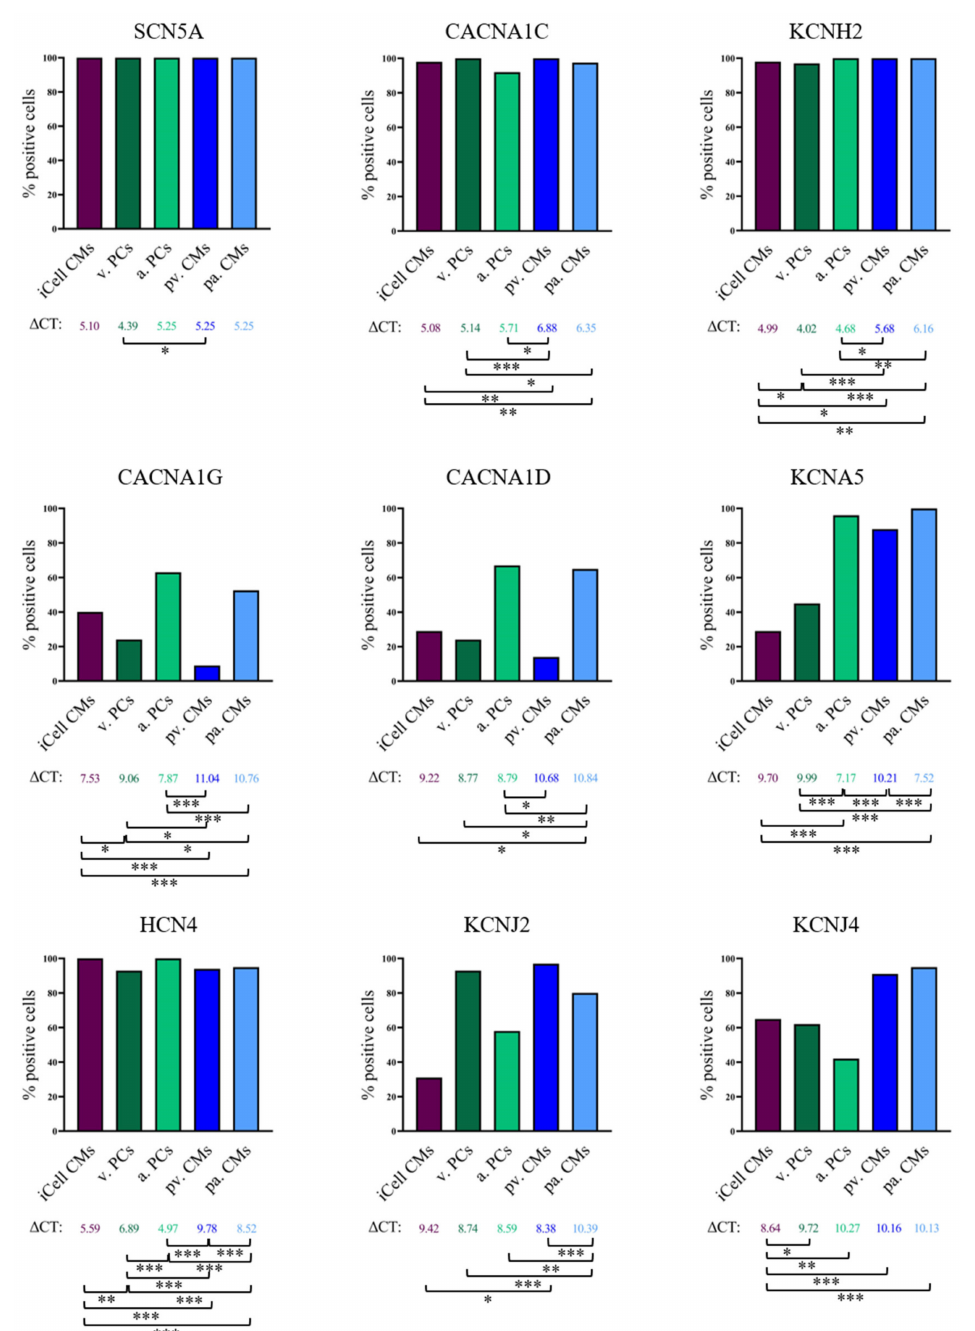
Figure 3. Comparison of cardiomyocyte groups regarding ion channel expression at the single-cell level. Columns represent percentages of positive cells; values shown below the columns are mean ∆ CT values (CT values normalized to the mean expression of TNNT2 and GAPDH of the respective cell group) of the positive cells. Students t -test was used to compare the ∆ CT values between the groups. Significant differences of ∆ CT values between groups are indicated with * p < 0.05, ** p < 0.01 and *** p < 0.001. The total numbers used to calculate mean ∆ CT values are listed in Table 3. Abbreviations: iCell CMs, iCell cardiomyocytes; v. PCs, ventricular Pluricytes; a. PCs, atrial Pluricytes; pv. CMs, primary ventricular cardiomyocytes; pa. CMs, primary atrial